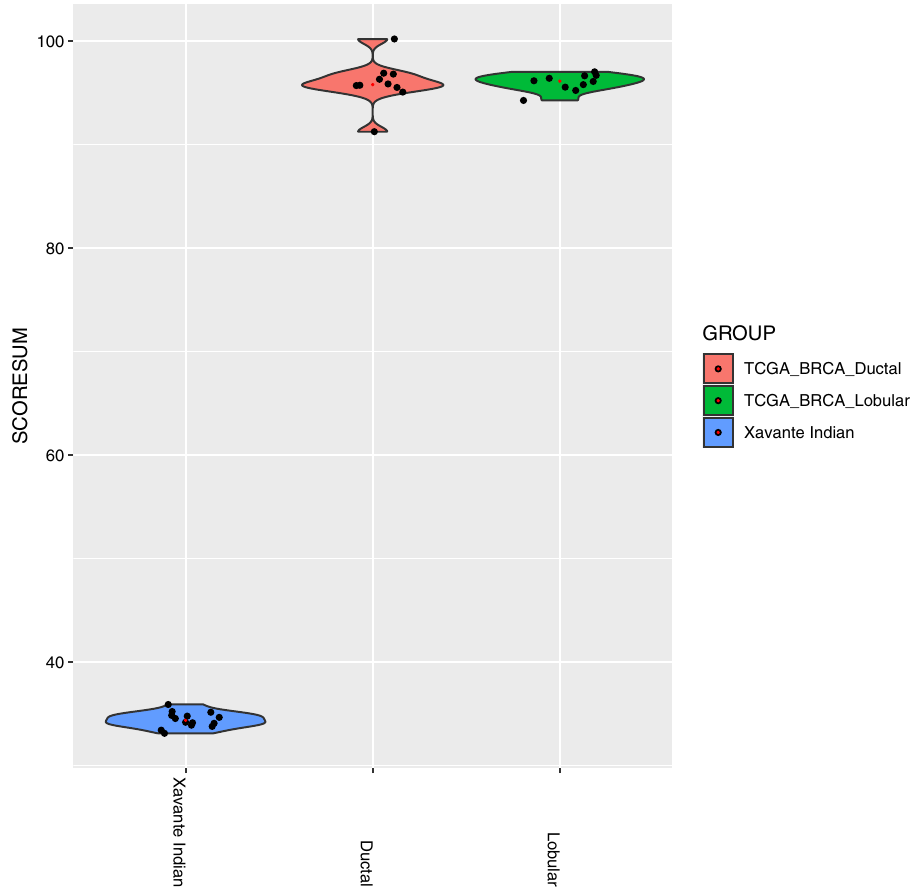
Figure 3. Violin plot of calculated polygenic risk scores of Xavante Indian samples and TCGA normal breast cancer control samples to compare the genetic risk for breast cancer of Xavante Indians and TCGA breast cancer normal controls. Each dot represents the polygenic risk score of one sample. Wilcoxon–Mann–Whitney test p value < 0.0001 indicated extremely significant difference between